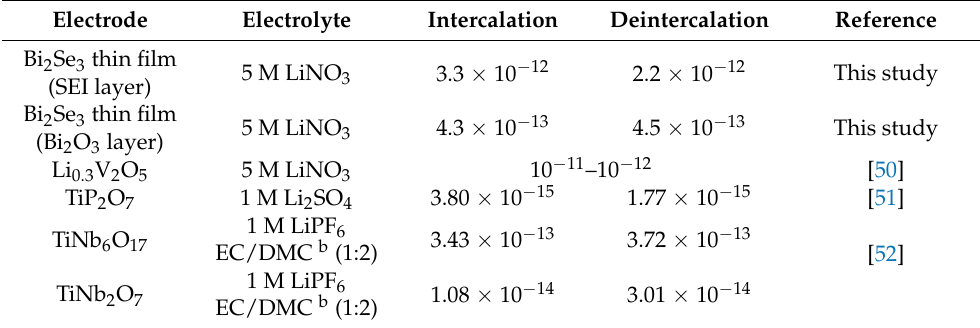
Table 2. Comparison of Li + intercalation and deintercalation diffusion coefficients (cm 2 s − 1 ) for dif- ferent anodes and electrolytes.